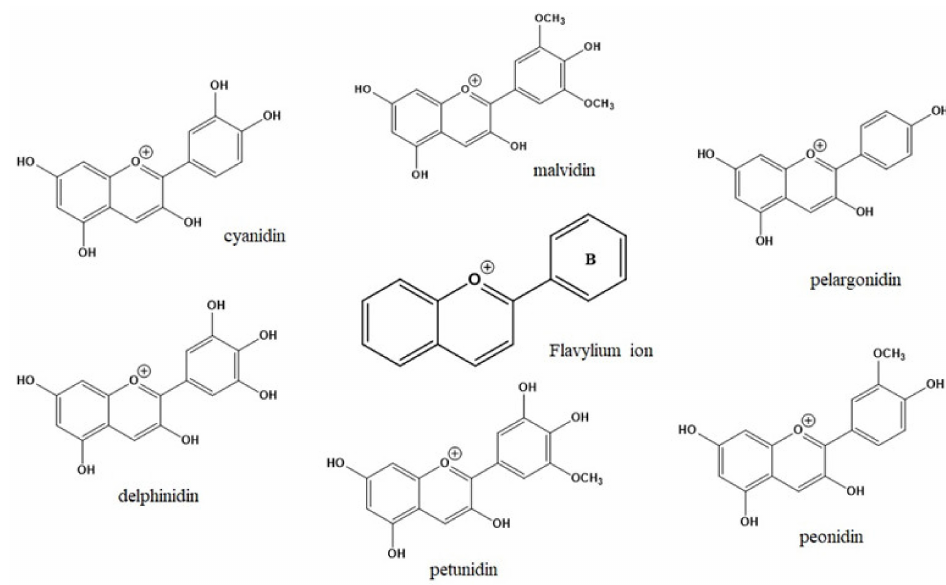
Figure 1. The chemical structures of flavylium ion and its derivatives known as anthocyanidins. Chemical Stability and Bioavailability of